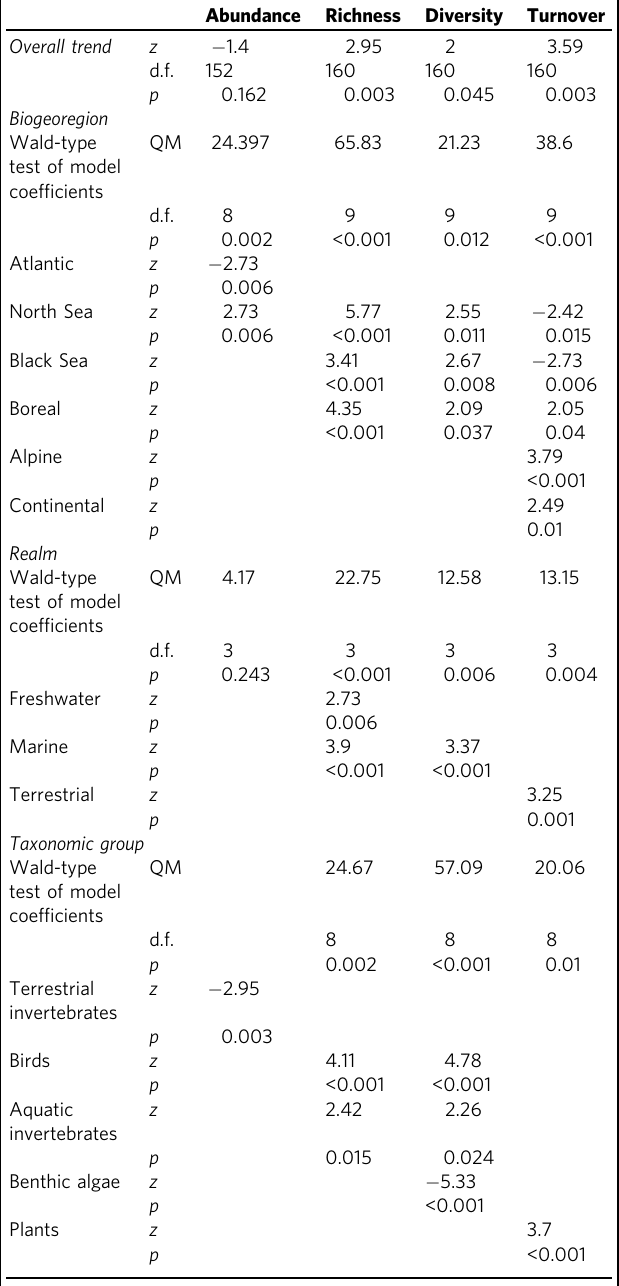
Table 1 Biodiversity